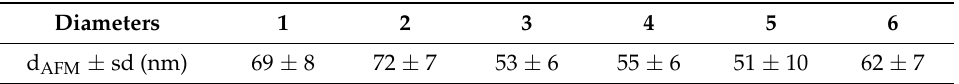
Table 2. Nanogels 1 to 6 diameters (d AFM ) in function of CS concentration and Gd contrast